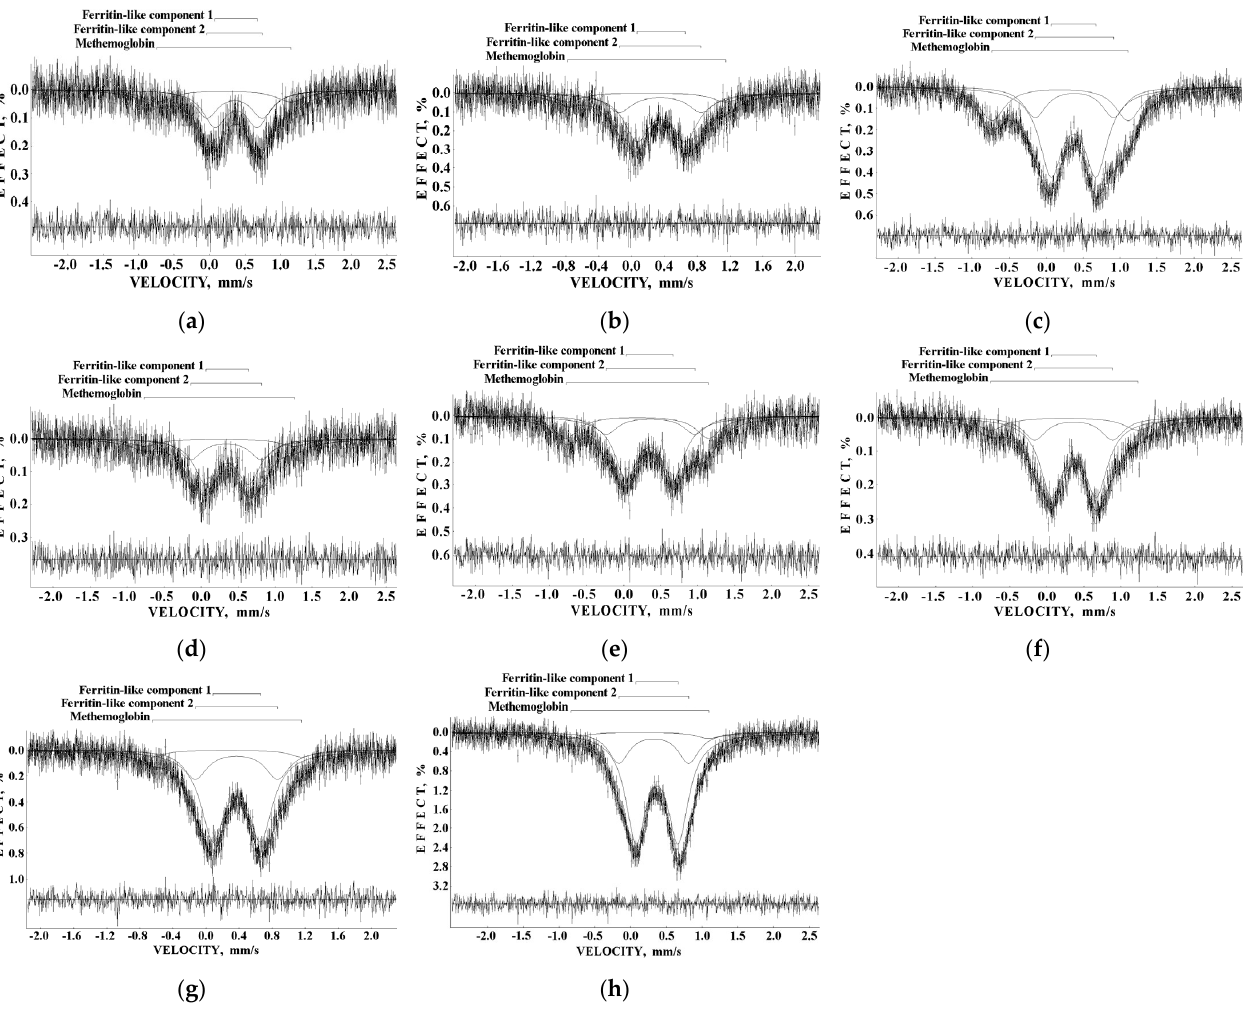
Figure 12. Mössbauer spectra of spleen tissues from normal human “1” ( a ) and patients with man‑ tle cell lymphoma “N” ( b ) and “G” ( c ), marginal zone lymphoma “De” ( d ), “Do” ( e ) and “P” ( f ), acute myeloid leukemia “Ch” ( g ), and primary myelofibrosis “B” ( h ) fitted within the simple het‑ erogeneous model for the ferritin‑like iron cores (doublets 1 and 2) and component 3 for residual methemoglobin. The differential spectra are shown on the bottom. Adapted from Ref. [59] with permission from Springer Nature: Cell Biochemistry and Biophysics, “The iron state in spleen and liver tissues from patients with hematological malignancies studied using magnetization measure‑ ments and Mössbauer spectroscopy”, Alenkina I.V., Vinogradov A.V., Felner I., Konstantinova